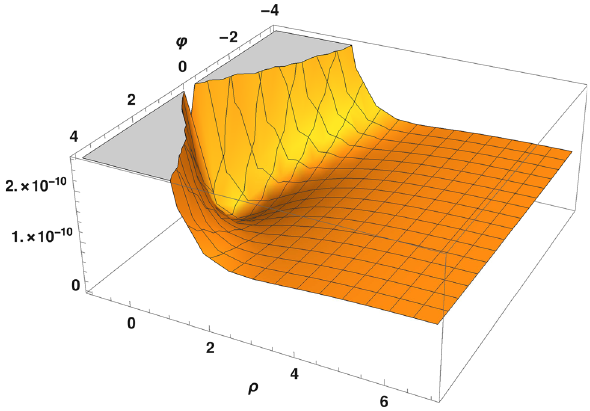
Fig. 6 The potential V (φ,ρ) for α = 0 . 01, β = 0 . 001 and m = M = 1 . 3 · 10 − 5